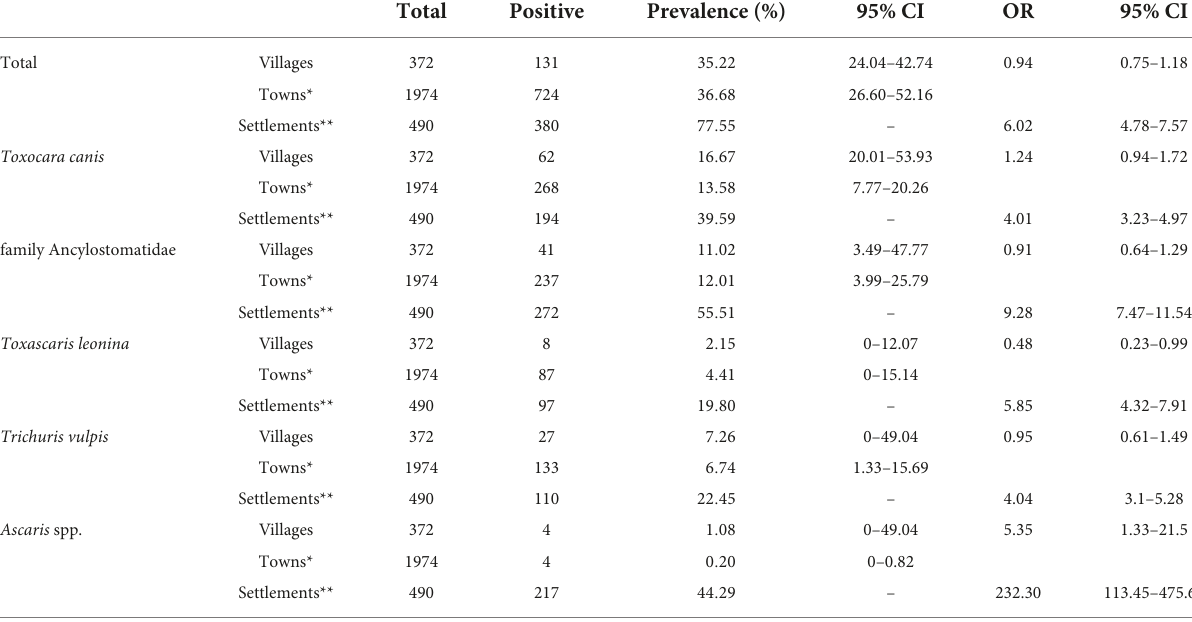
TABLE 3 Soil-transmitted helminths (STH) prevalence in the dogs’ excrement is categorized by the environment. Total